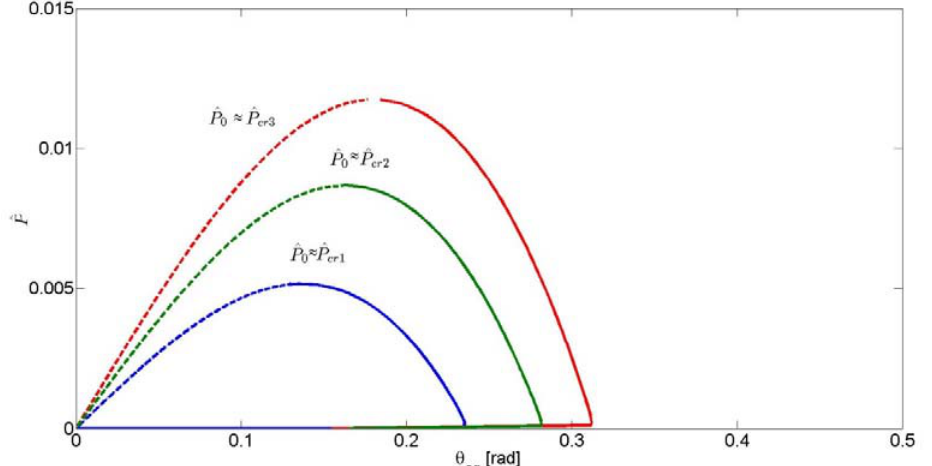
ˆ P is equal to the  when the load 0 eq